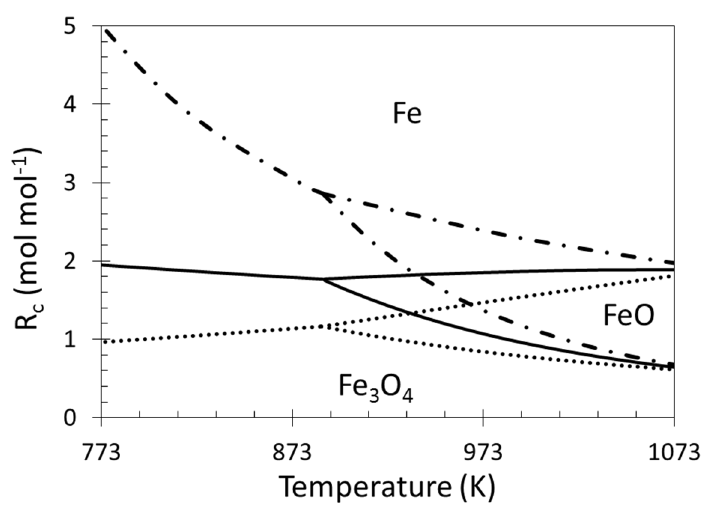
Figure 2. Phase diagram for the equilibrium between iron and its oxides (Fe 3 O 4 , FeO and Fe) as a function of temperature and feed gas reduction capacity: − · − H 2 /H 2 O; − H 2 /CO/H 2 O/CO 2 (C and H 2 equimolar amount, representing a feed of CH 4 + CO 2 ); ····· CO/CO 2 [38] .